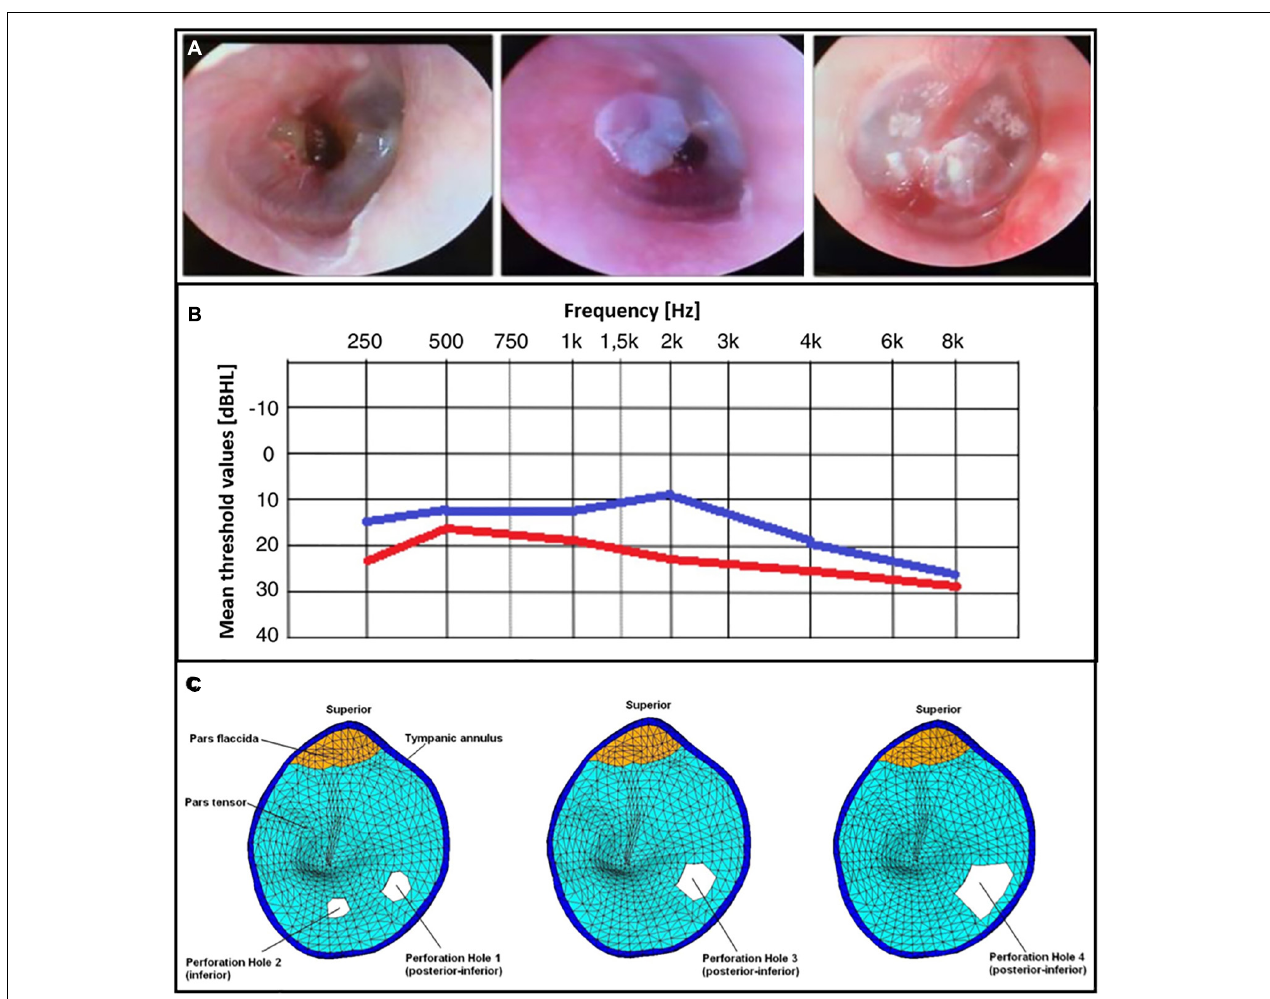
FIGURE 2 | (A) Patients’ otoscopy procedures after the BC film placement. Reprinted with permission. (B) Tonal audiometry that compares the means values before (in red color) and after (in blue color) a BC placement across frequencies (de et al., 2020) © Creative Commons Attribution License, 1969, Elsevier. (C) Perforations of the TM modeled with a FEM. Reprinted with permission (Gan et al., 2009) © 2009 Acoustical Society of